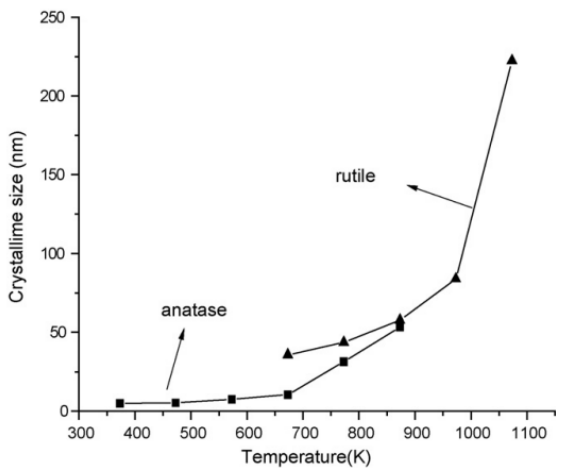
Figure 6. Effect of thermal treatment temperature on crystallite size of TiO 2 . Reprinted with permis- sion from Ref. [161] . Copyright 2007, Elsevier.